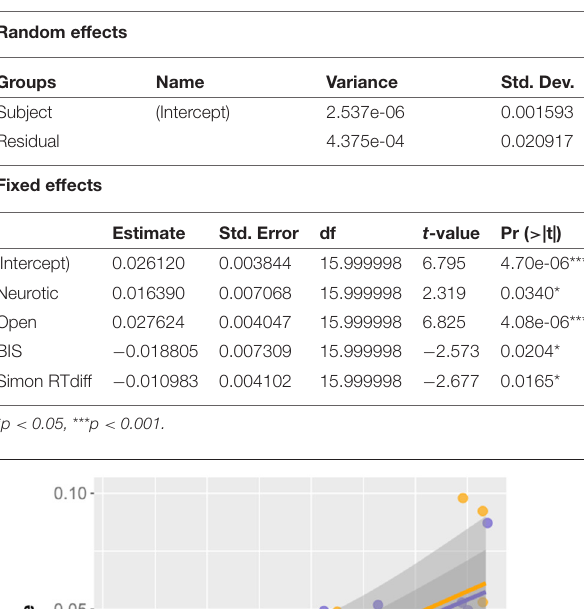
TABLE 4 | Random and fixed effects in the linear mixed model for convergence and the psychological and cognitive variables (significance values for the coefficients are based on t -tests using the Satterthwaite’s method, provided within the lmerTest package).